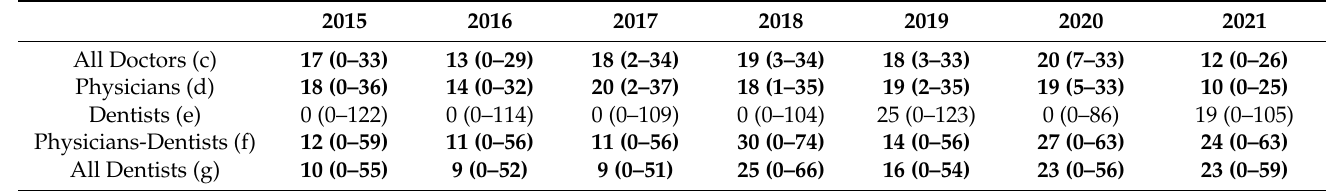
Table 4. SMR% (CI95%). Registered doctors vs. general population of the province of